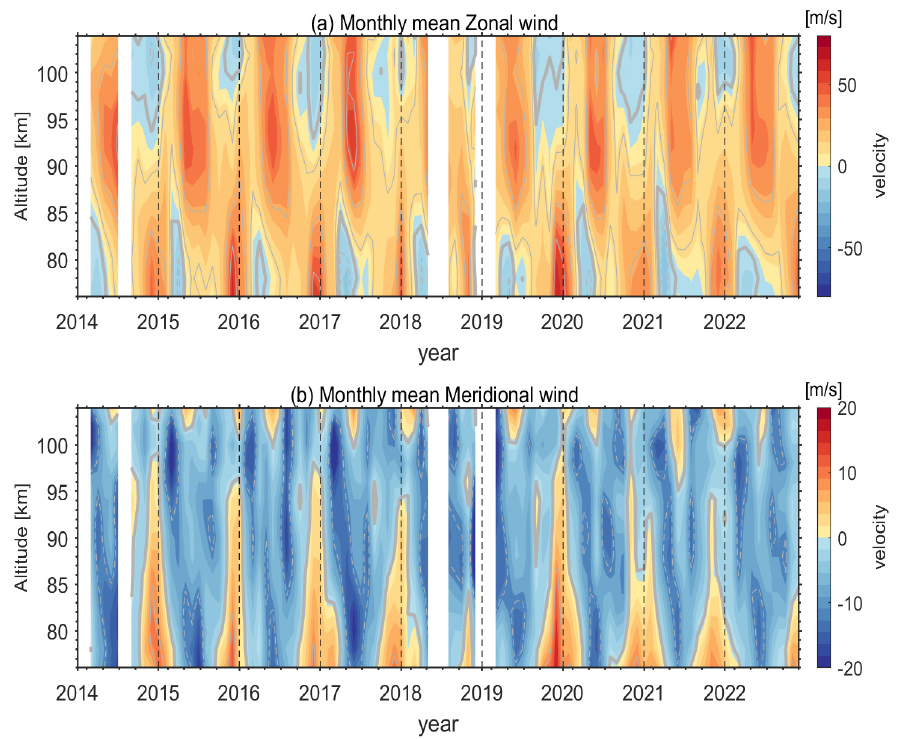
Figure 2. ( a ) Monthly mean zonal (eastward is positive) and ( b ) meridional (northward is positive) winds from 2014 to 2022 observed by the Mengcheng meteor radar between altitudes of 76 and 106